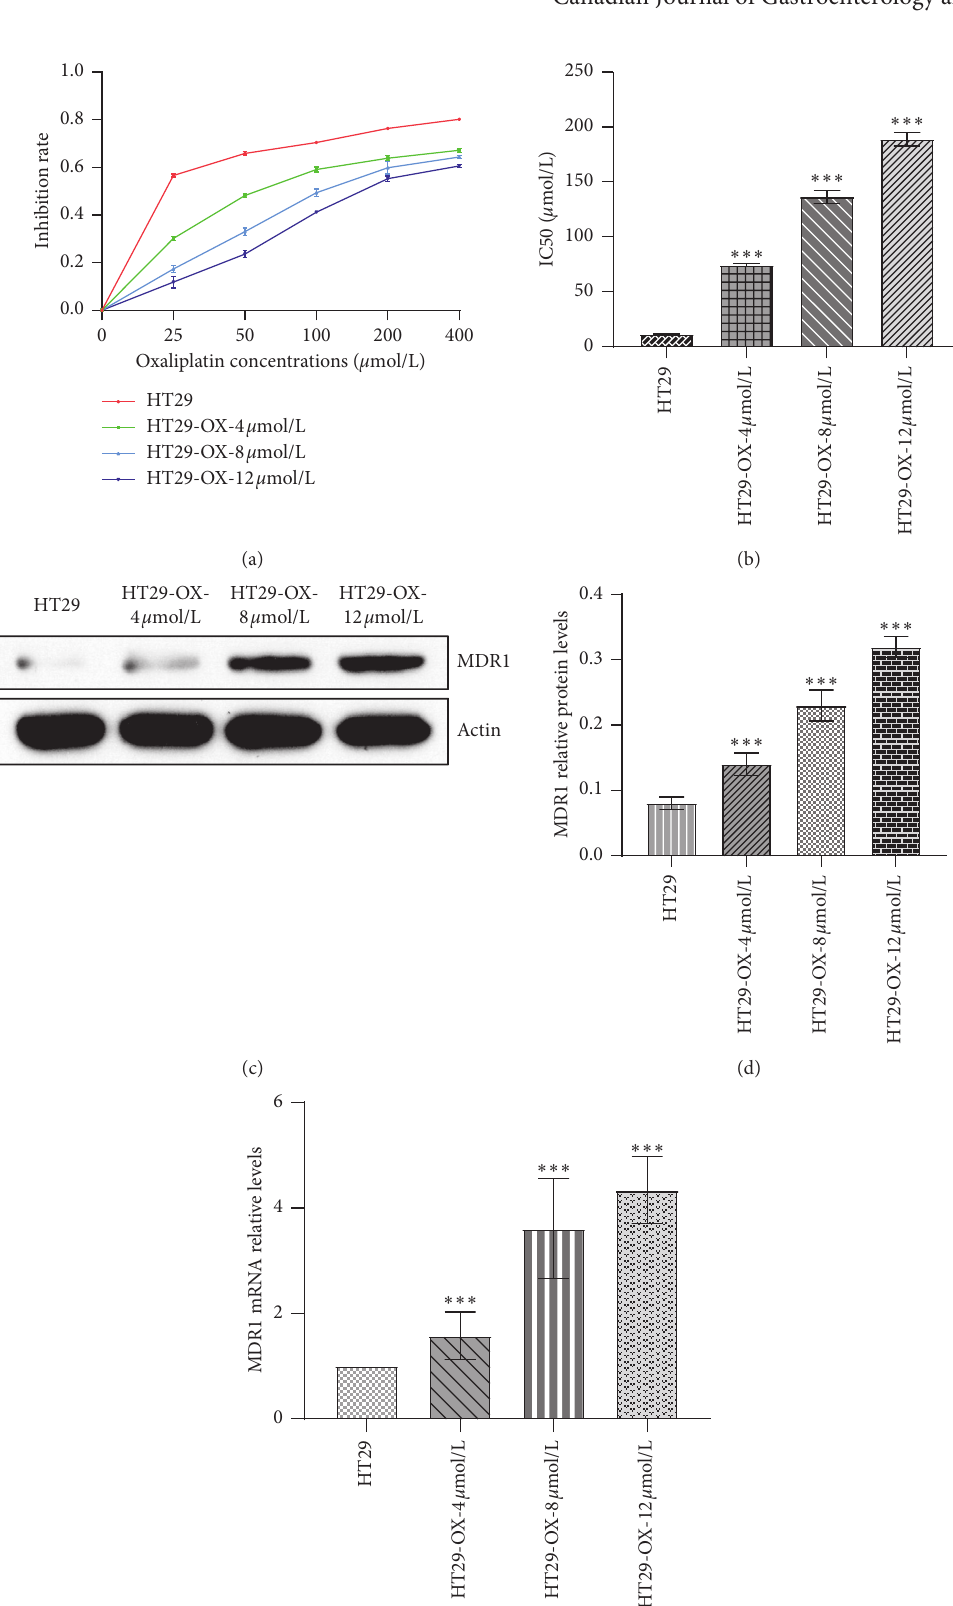
Figure 3: The oxaliplatin-resistant model of P53 mutant colon cancer cell HT29 was successfully constructed. (a) Inhibitory curves of HT29, HT29-OX-4 μ mol/L, HT29-OX-8 μ mol/L, and HT29-OX-12 μ mol/L. (b) The IC50 value of HT29, HT29-OX-4 μ mol/L, HT29-OX-8 μ mol/ L, and HT29-OX-12 μ mol/L. (c) Relative protein expression of MDR1 in HT29, HT29-OX-4 μ mol/L, HT29-OX-8 μ mol/L, and HT29-OX- 12 μ mol/L. (d) The quantitative analysis of (c). (e) Relative mRNA level of MDR1 in HT29, HT29-OX-4 μ mol/L, HT29-OX-8 μ mol/L, and HT29-OX-12 μ mol/L. ∗∗∗ P < 0 . 05. Data among multiple groups were analyzed by one-way ANOVA, followed by Tukey’s post hoc test. Data among multiple groups in skew distribution were tested by the nonparametric Kruskal–Wallis H